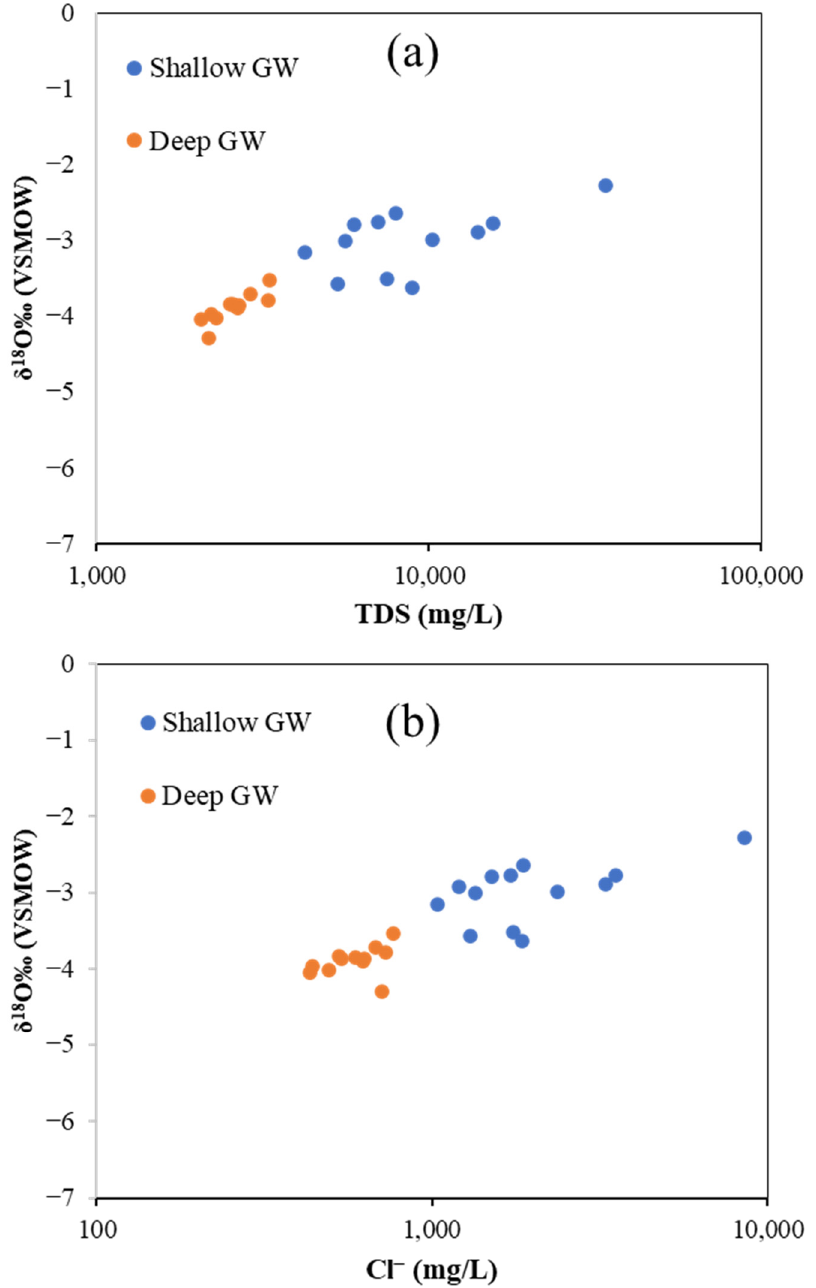
Figure 17. Plot showing the relationship between δ 18 O and hydrochemical parameters (TDS and Cl − ) of analyzed GW and seawater samples; ( a ) TDS versus δ 18 O, and ( b ) Cl − versus δ 18